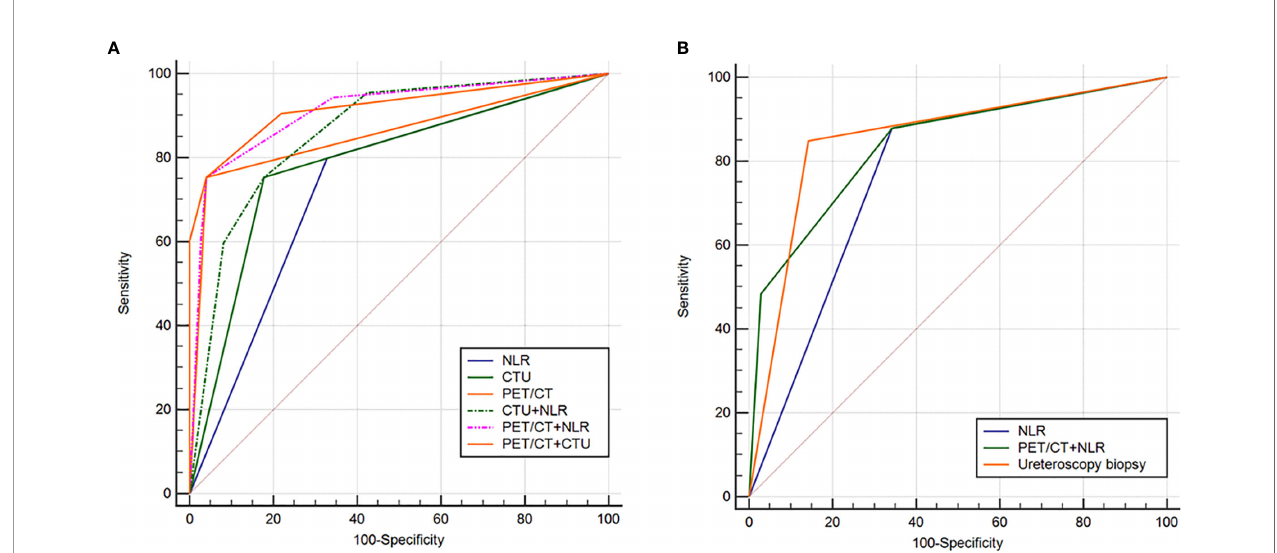
FIGURE 4 | Receiver operating characteristic (ROC) curve analysis to evaluate the predictive ability of various diagnostic methods in distinguishing benign from malignant lesions of upper urinary tract in the whole cohort (A) and patients requiring ureteroscopy biopsy (B) .